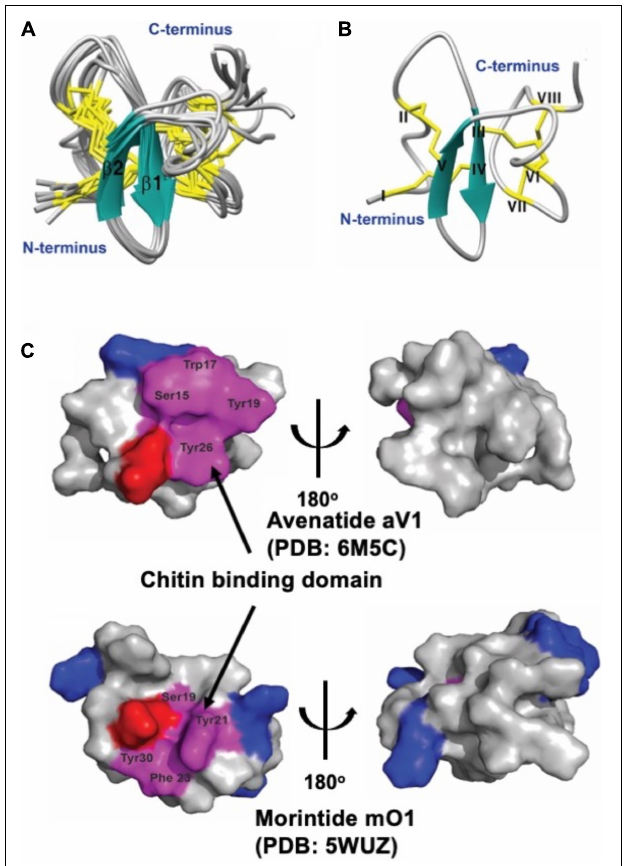
FIGURE 3 | Solution structure of avenatide aV1and comparison of the chitin-binding region with morintide mO1 which belongs to hevein-like domain. (A) Superposition of the avenatide aV1 backbone traces from the final 10 ensemble solution structures and restrained energy minimized structure. (B) Ribbon representation of avenatide aV1 structure. (C) Surface topology comparison of avenatide aV1 (PDB: 6M5C), and morintide mO1 (PDB: 5WUZ). Residues highlighted in purple represent the chitin-binding site. Residues highlighted in blue and red are basic (Arg, His, and Lys) and acidic (Asp, Glu),